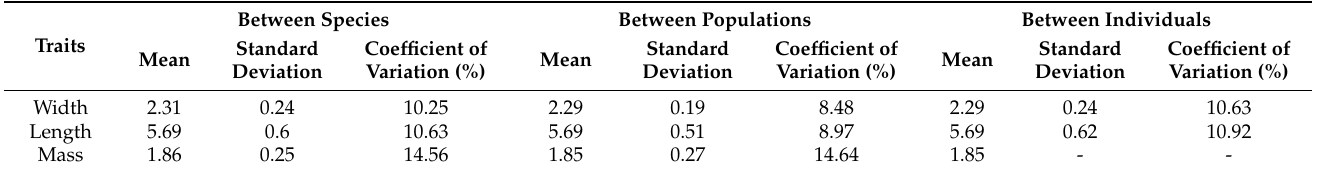
Table 2. Results of ANOVA for the analyzed traits in the three pine species.